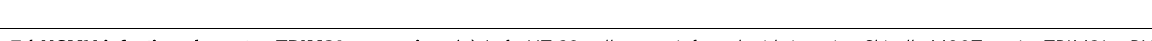
Figure 7 | HCMV infection abrogates TRIM31 expression. ( a ) Left, HT-29 cells were infected with invasive Shigella M90T strain. TRIM31 mRNA levels were determined by RT-PCR. Right, Quantification of TRIM31 mRNA levels normalized against GAPDH, which was used as a loading control. * P o 0.01 (Student’s t -test). ( b ) HT-29 cells were treated with LPS (100ngml (cid:2) 1 ) for 0, 1 or 3h, and then TRIM31 mRNA was measured by RT-PCR. Right , Quantification of TRIM31 mRNA levels normalized against GAPDH, which was used as a loading control. * P o 0.01 (Student’s t -test). ( c ) TRIM31 mRNA was measured by RT-PCR in HeLa cells treated with LPS (100ngml (cid:2) 1 ) for 0, 1 or 3h. * P o 0.01 (Student’s t -test). ( d ) Cell death was assessed by propidium iodide (PI) staining of mock or TRIM31-Myc-expressing HeLa cells infected with M90T-GFP followed by flow cytometric analysis. Values represent the average of three independent experiments. * P o 0.05 (Student’s t -test). ( e ) HCMV infection down-regulates TRIM31 expression. Wild-type HCMV AD169 strain was infected into the intestinal epithelial cell line, Caco-2, for 48h, and then HCMV immediate early gene (IE1), LC3, or TRIM31 mRNA was measured by RT-PCR. ( f ) Quantification of TRIM31 and LC3 mRNA levels normalized against GAPDH. * P o 0.01 (Student’s t -test). ( g ) HCMV-infected intestinal cells show a considerable increase in bacteria load. Intestinal cells were infected with HCMV for 48h, followed by infection with Shigella prior to measuring the degree of bacterial growth. TRIM31 or IE1 mRNA levels were determined by RT-PCR. Values represent the average number of colonies from three independent experiments. * P o 0.01 (Student’s t -test). All data are representative of at least three independent experiments (mean ± s.d. in a – d , f – g ). ( h ) Proposed model of TRIM31-mediated alternative autophagy process in the intestinal epithelial